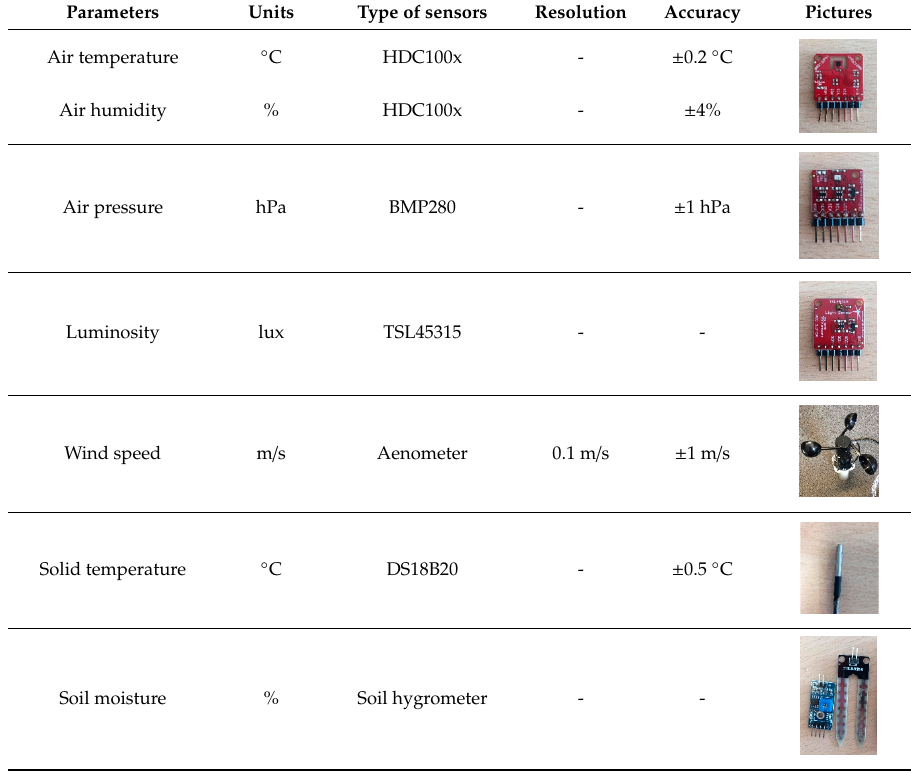
Figure 4. Experiment setup and sensor placement (green façade in Ettlingen, Germany). Table 1. Measured parameters. The type of sensors measuring for individual parameters are listed out. Parameters